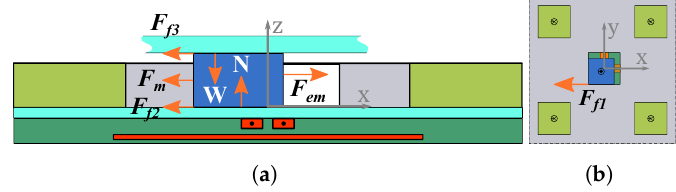
Figure 4. EDA’s free body diagram ( a ) Side view. ( b ) Top